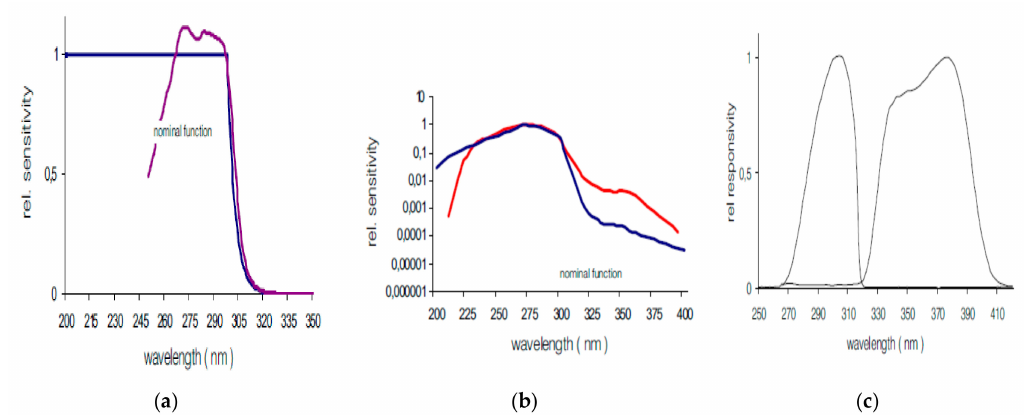
Figure 1. Relative sensitivity of the di ff erent types of electronic dosimeters used for the individual UV measurement campaign in fishermen in comparison with the relative weighting function (curves in blue): ( a ) erythemally weighted; ( b ) International Commission on Non-Ionizing Radiation Protection weighted; ( c ) unweighted (with a specific response, which is a function of the